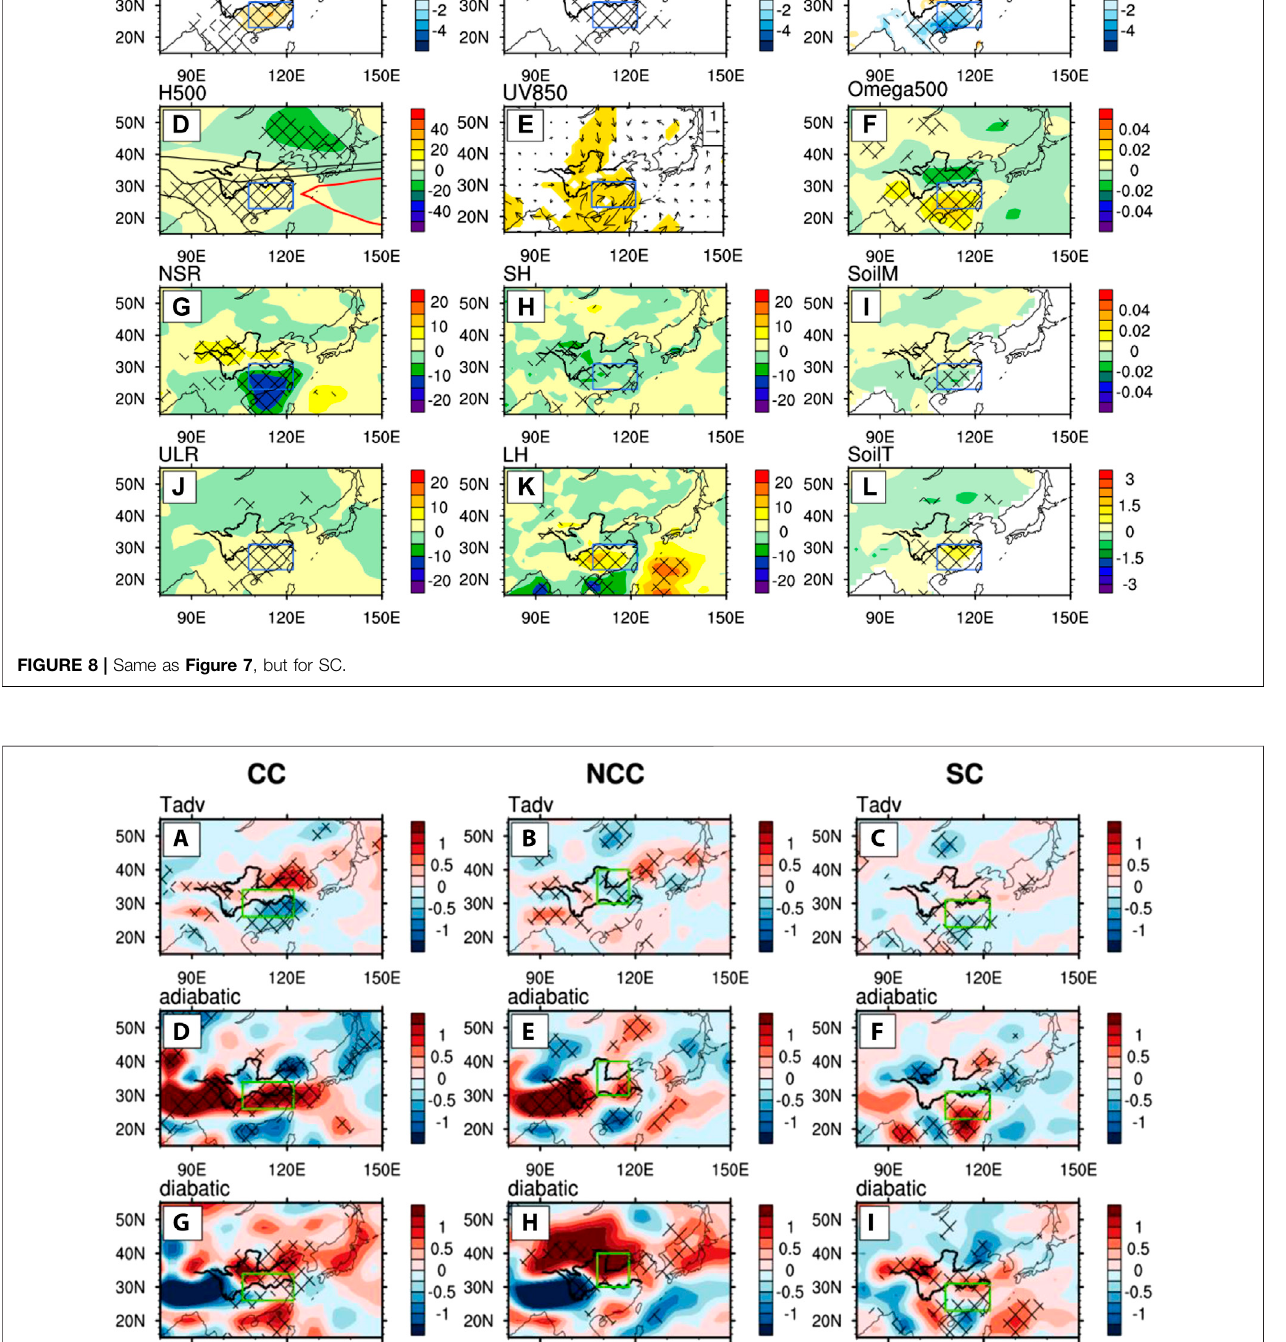
Frontiers in Earth Science |